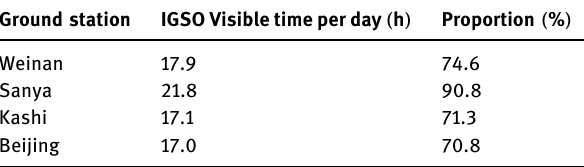
Table 1: Visible time of the IGSO to ground station Ground station